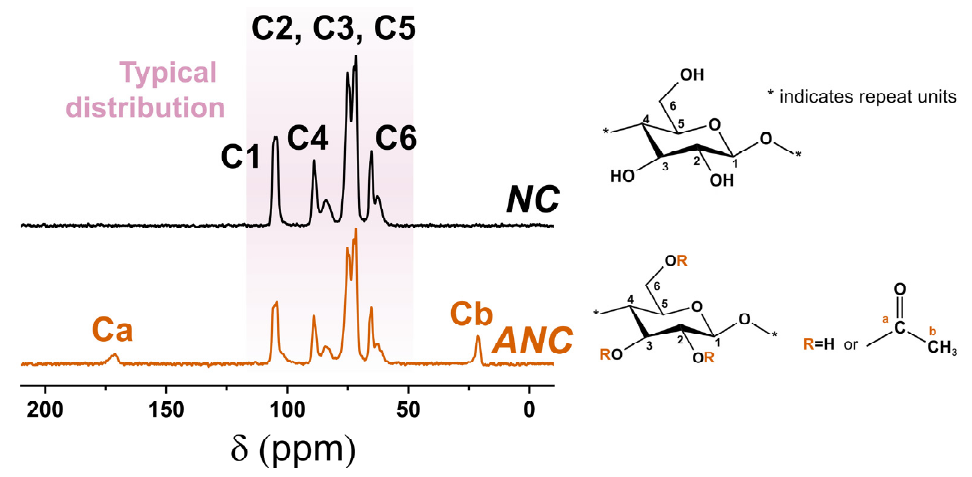
Figure 2. NMR spectra of as-received nanocelluloses (NCs) and acetylated nanocelluloses (ANCs), accompanied by schematic of substituted groups.